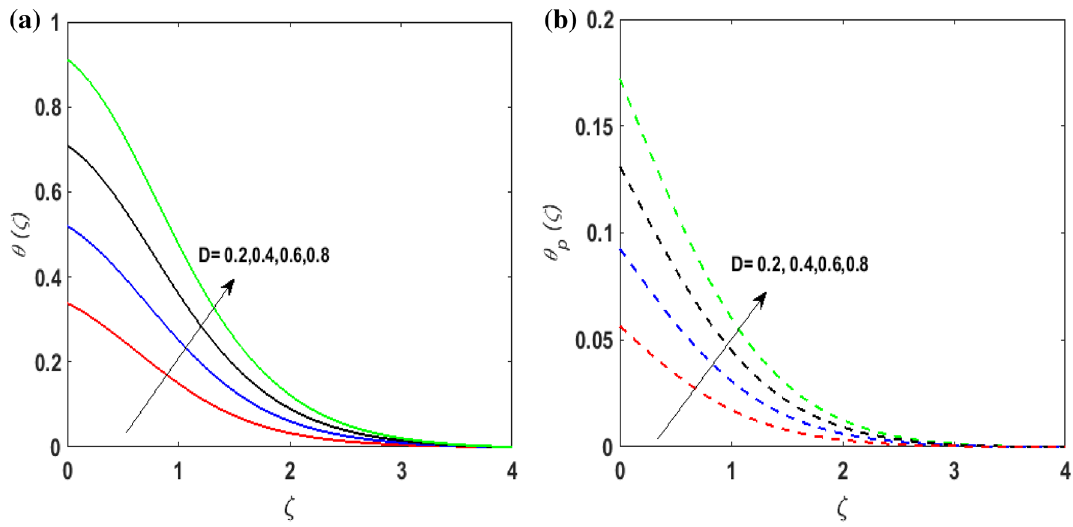
Figure 11. ( a ) θ(ζ) for various D > 0. ( b ) θ p (ζ) for various D >